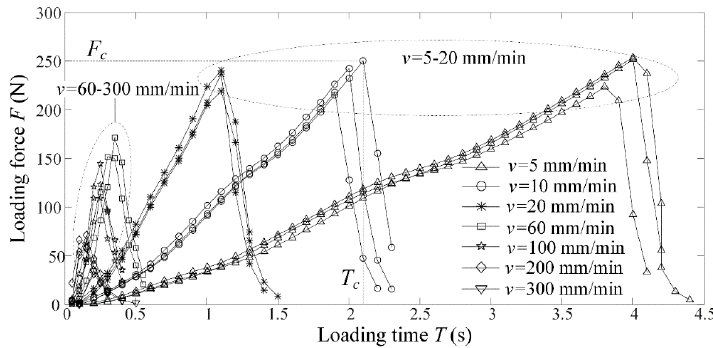
Figure 7. Loading force F and loading time T versus loading rate v .